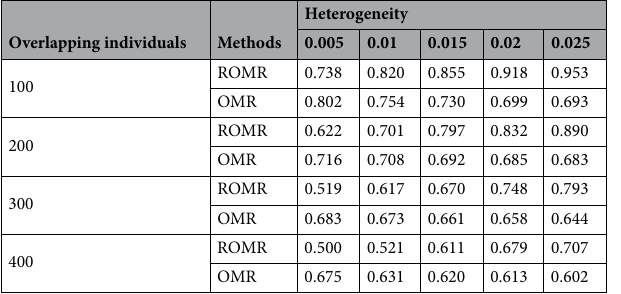
Overlapping individuals